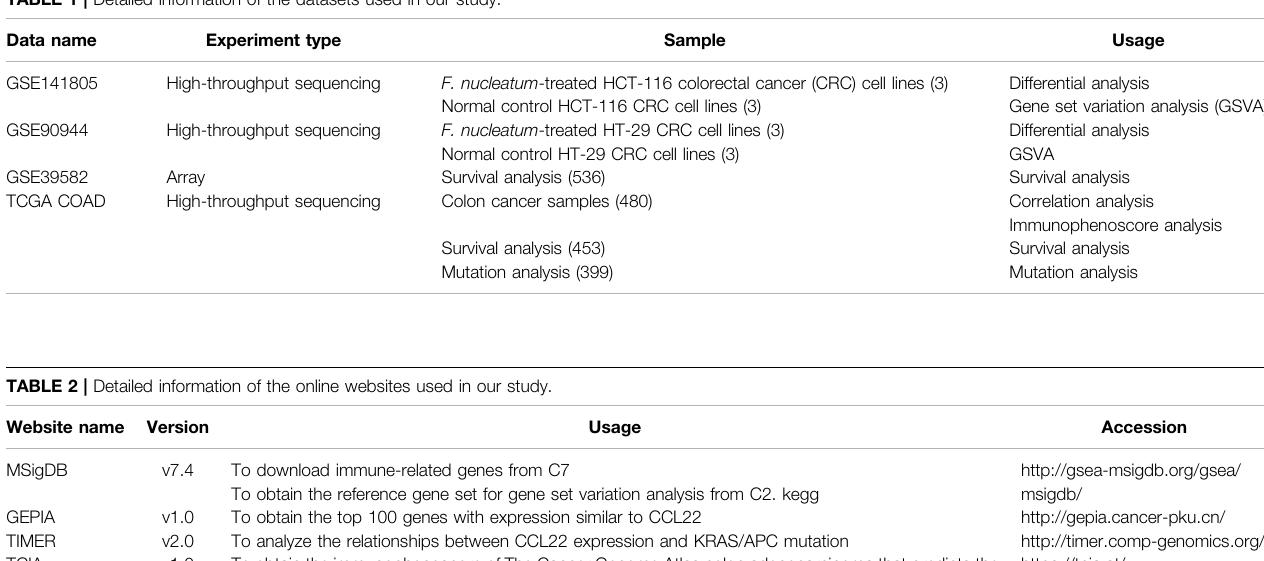
TABLE 1 | Detailed information of the datasets used in our study.